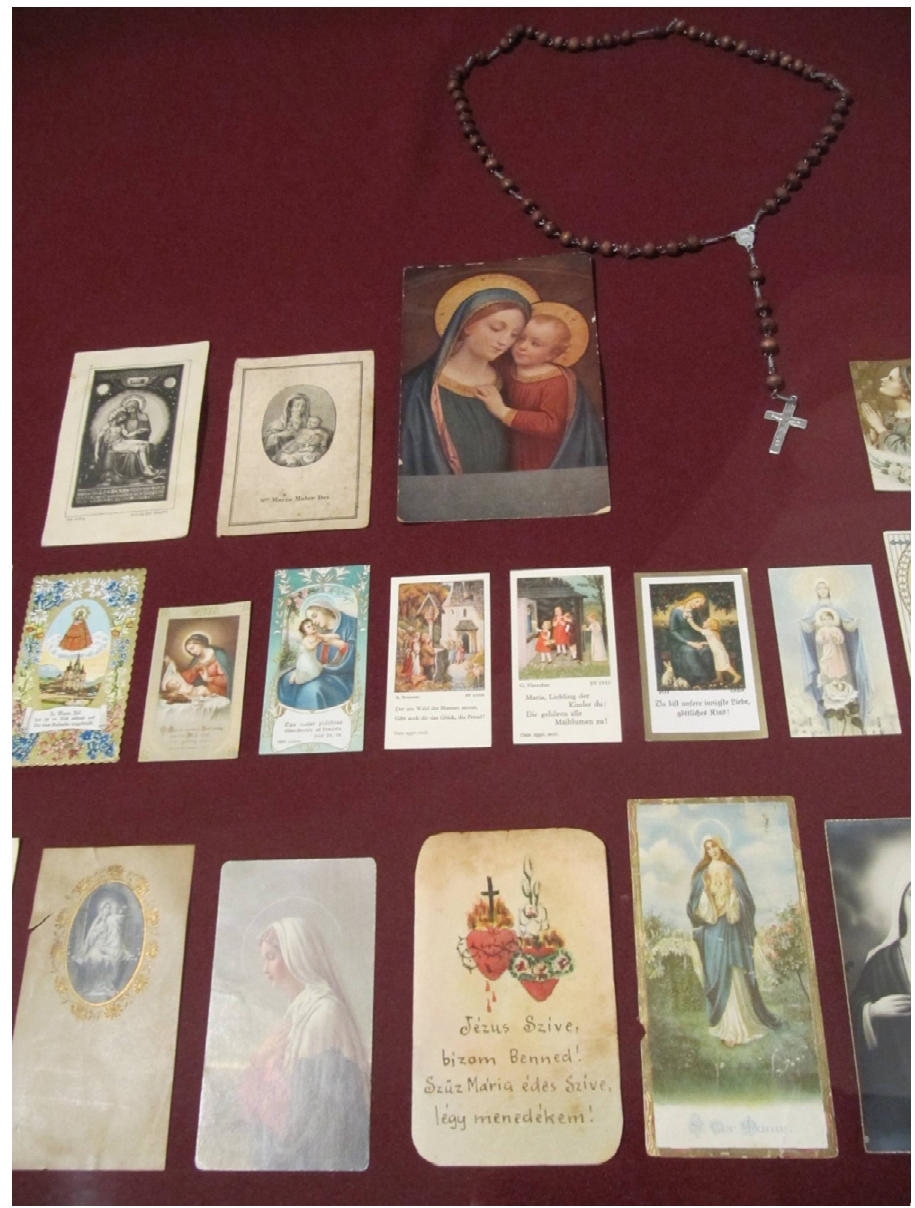
Figure 7. Exhibition Case Containing Mass Produced Prayer